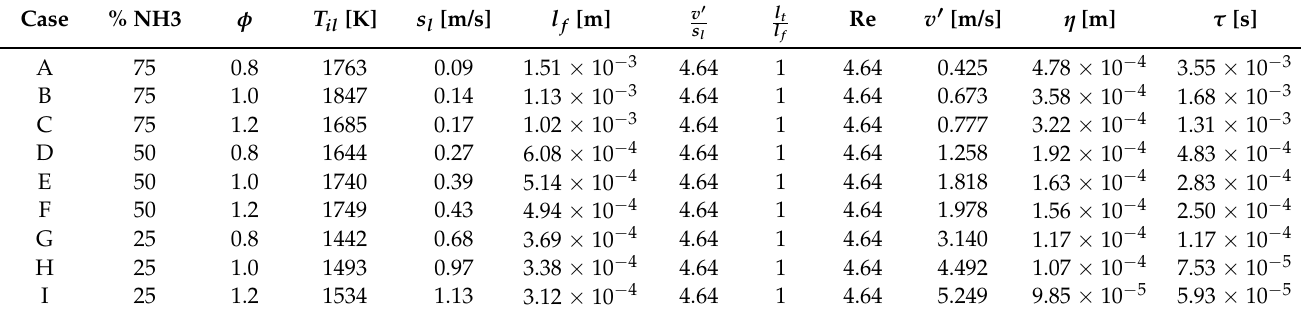
Table 1. Database of the simulation parameters used for the DNS